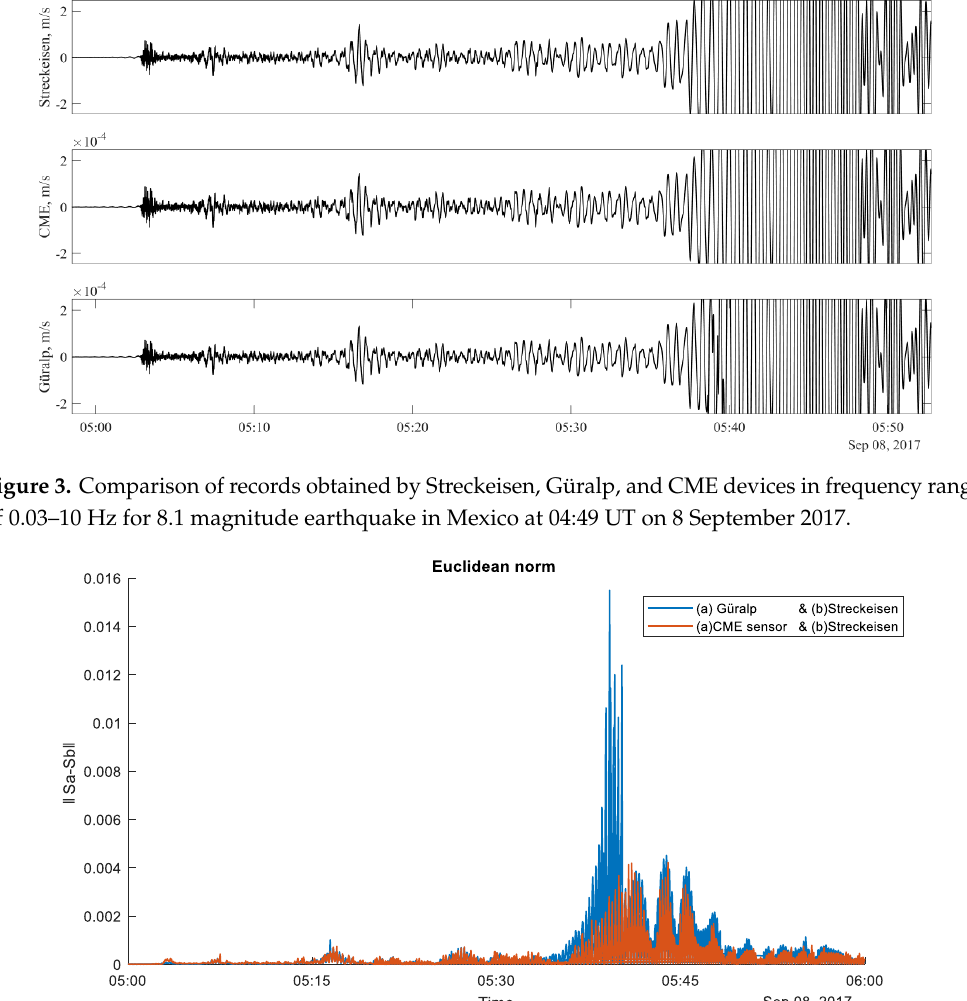
Figure 4. Euclidean norm that represent similarity between two pairs of signals recorded: Streckeisen and Güralp (blue), Streckeisen and CME sensor (red) in frequency range of 0.03–10 Hz for the same data shown on Figure 3. (Earthquake in Mexico at 04:49 UT on 8 September 2017).